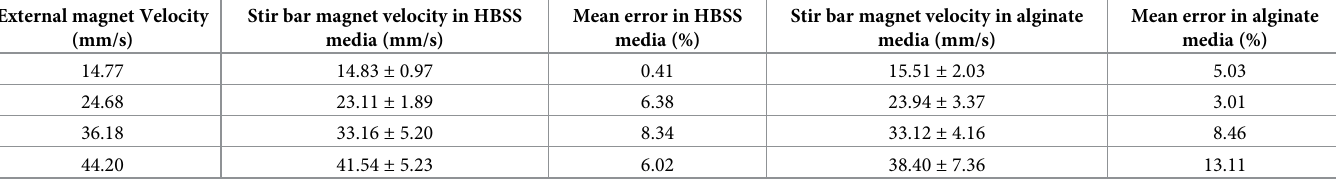
Table 2. Translational velocities of both the external and stir bar magnets during agitation.